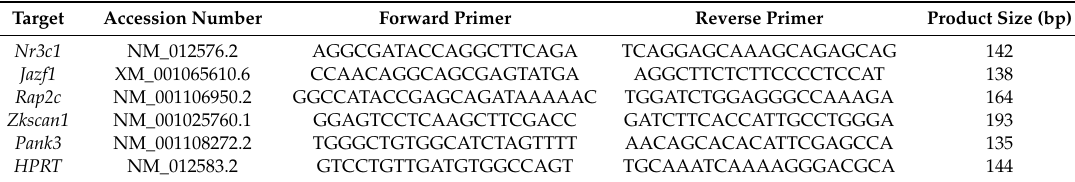
Table 3. Primer properties used in qRT-PCR for the determination of transcript levels. Nr3c1 ,